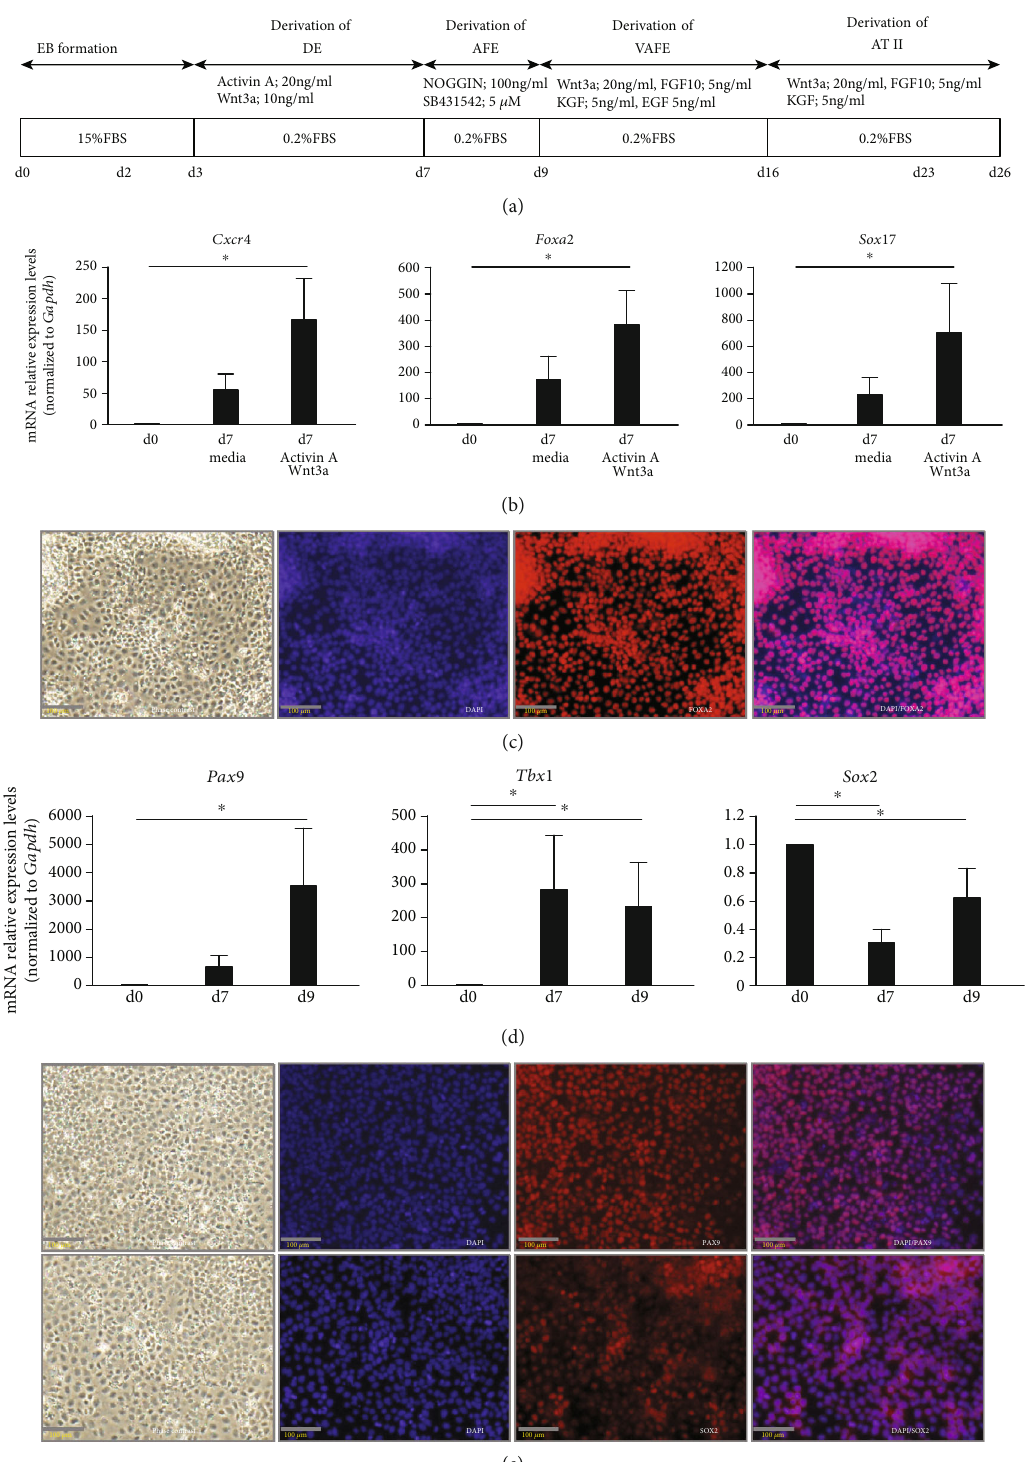
Figure 1: (a) Di ff erentiation protocols for the derivation of ATII using an embryoid body seeding method and a stepwise di ff erentiation method. (b) Quantitative polymerase chain reaction analysis of DE (day 7) ( n = 5 ). Expression of Cxcr4 , Foxa2 , and Sox17 mRNA. Expression ratios were normalized to the level of Gapdh expression. Expression levels were compared with those of undi ff erentiated iPSCs (day 0). ∗ P < 0 : 05 . (c) Phase-contrast image and immuno fl uorescence images of FOXA2 in DE (day 7). Scale bars: 100 μ m. (d) Quantitative polymerase chain reaction analysis of AFE (day 9) ( n = 4 ). Expression of Pax9 , Tbx1 , and Sox2 mRNA. Expression ratios were normalized to the level of Gapdh expression. Expression levels were compared with those of undi ff erentiated iPSCs (day 0). ∗ P < 0 : 05 . (e) Phase-contrast image and immuno fl uorescence images of PAX9 and SOX2 in AFE (day 9). Scale bars: 100 μ